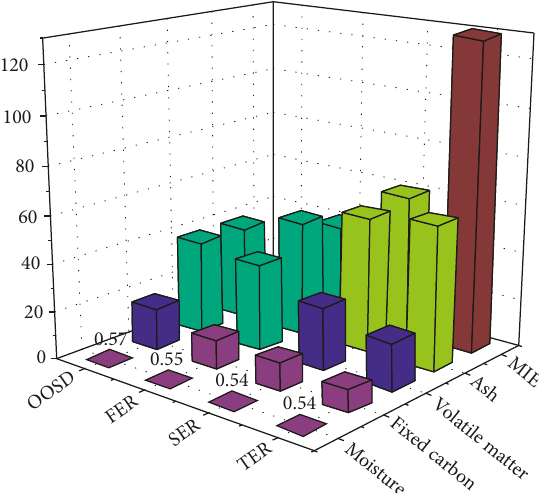
Figure 7: The industrial analysis results of oil shale dust and the variation tendency of the